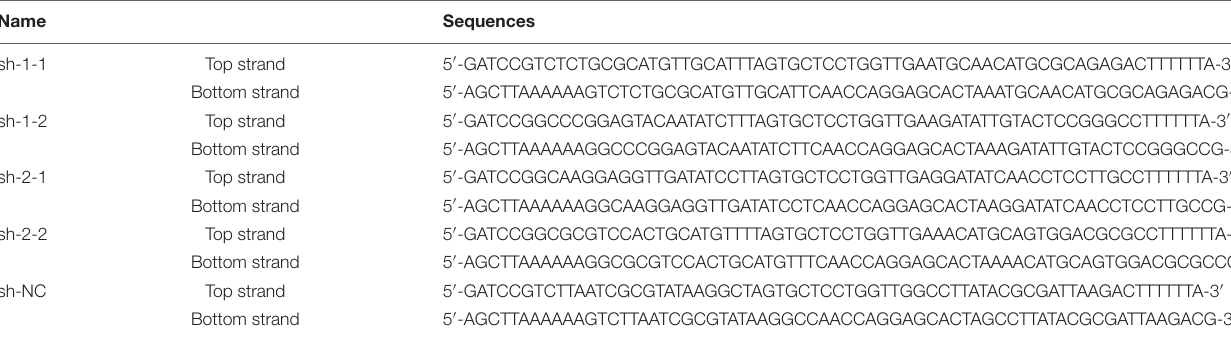
TABLE 1 | Synthetic shRNA oligonucleotide